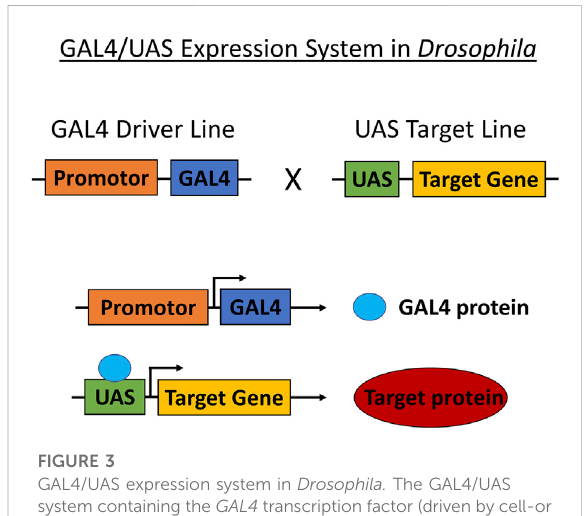
FIGURE 3 GAL4/UAS expression system in Drosophila. The GAL4/UAS system containing the GAL4 transcription factor (driven by cell-or tissue-speci fi c enhancer/promoter) and UAS target used for targeting genetic manipulation in Drosophila. Transgenesare carried by crossing parent fl ies transferring either Enhancer - GAL4 or UAS-target gene that produces offspring translating the target